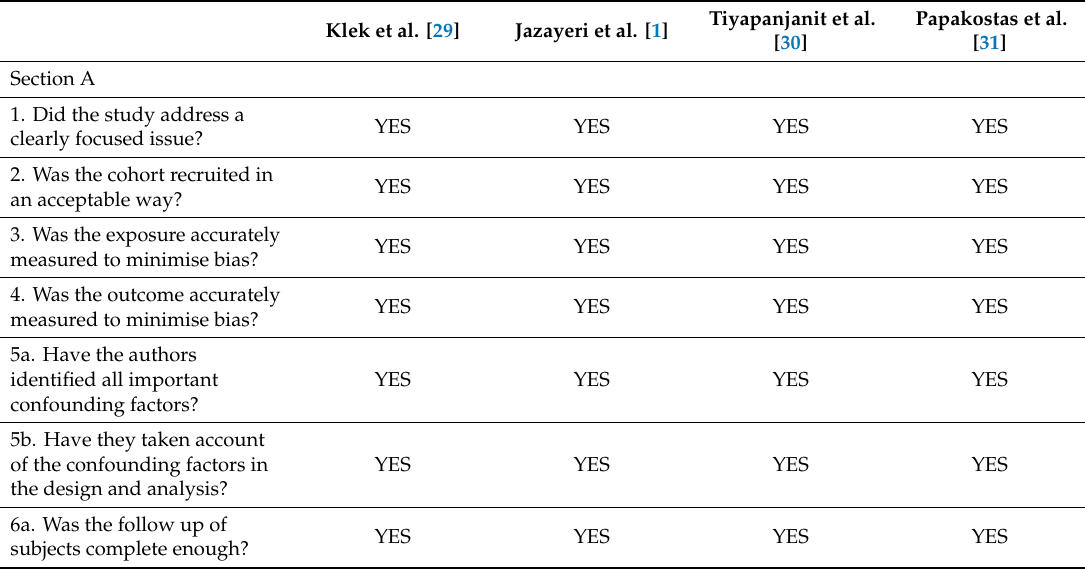
Table A1. CASP Critical Analysis Tool for cohort